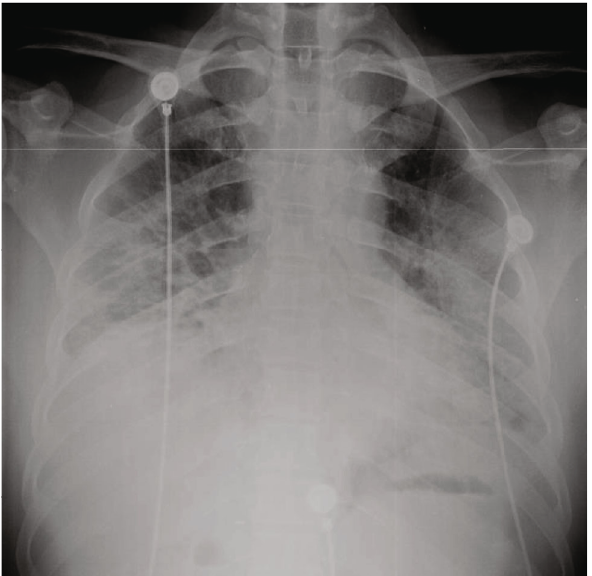
Figure 6: Chest radiograph of case 3 on day 3 of admission to ICU showing worsening of air space opaci fi cation in both lungs. More changes are seen on the left lung.